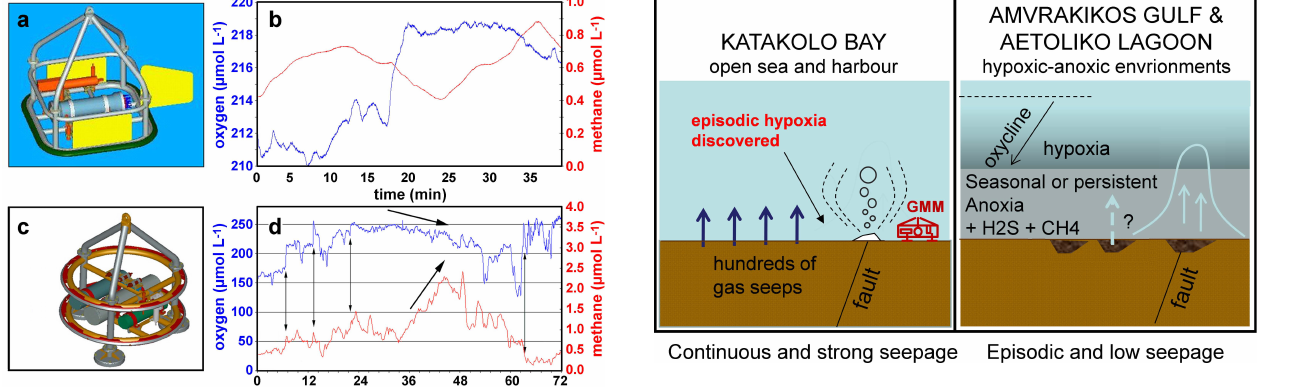
Fig. 12. Simplified graphical representation of the drivers of hy- poxia/anoxia in Katakolo Bay (left-hand panel), and in Amvrakikos Gulf and Aetoliko Lagoon (right-hand panel). “GMM” indicates the benthic observatory used for the time-series monitoring of dissolved gases: see text for